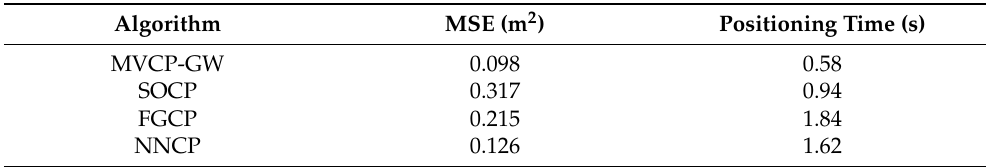
Table 1. Comparison of algorithm performance in non-mutation scene (ranging error variance σ 1 = 0.1 m, the number of vehicles n = 100).